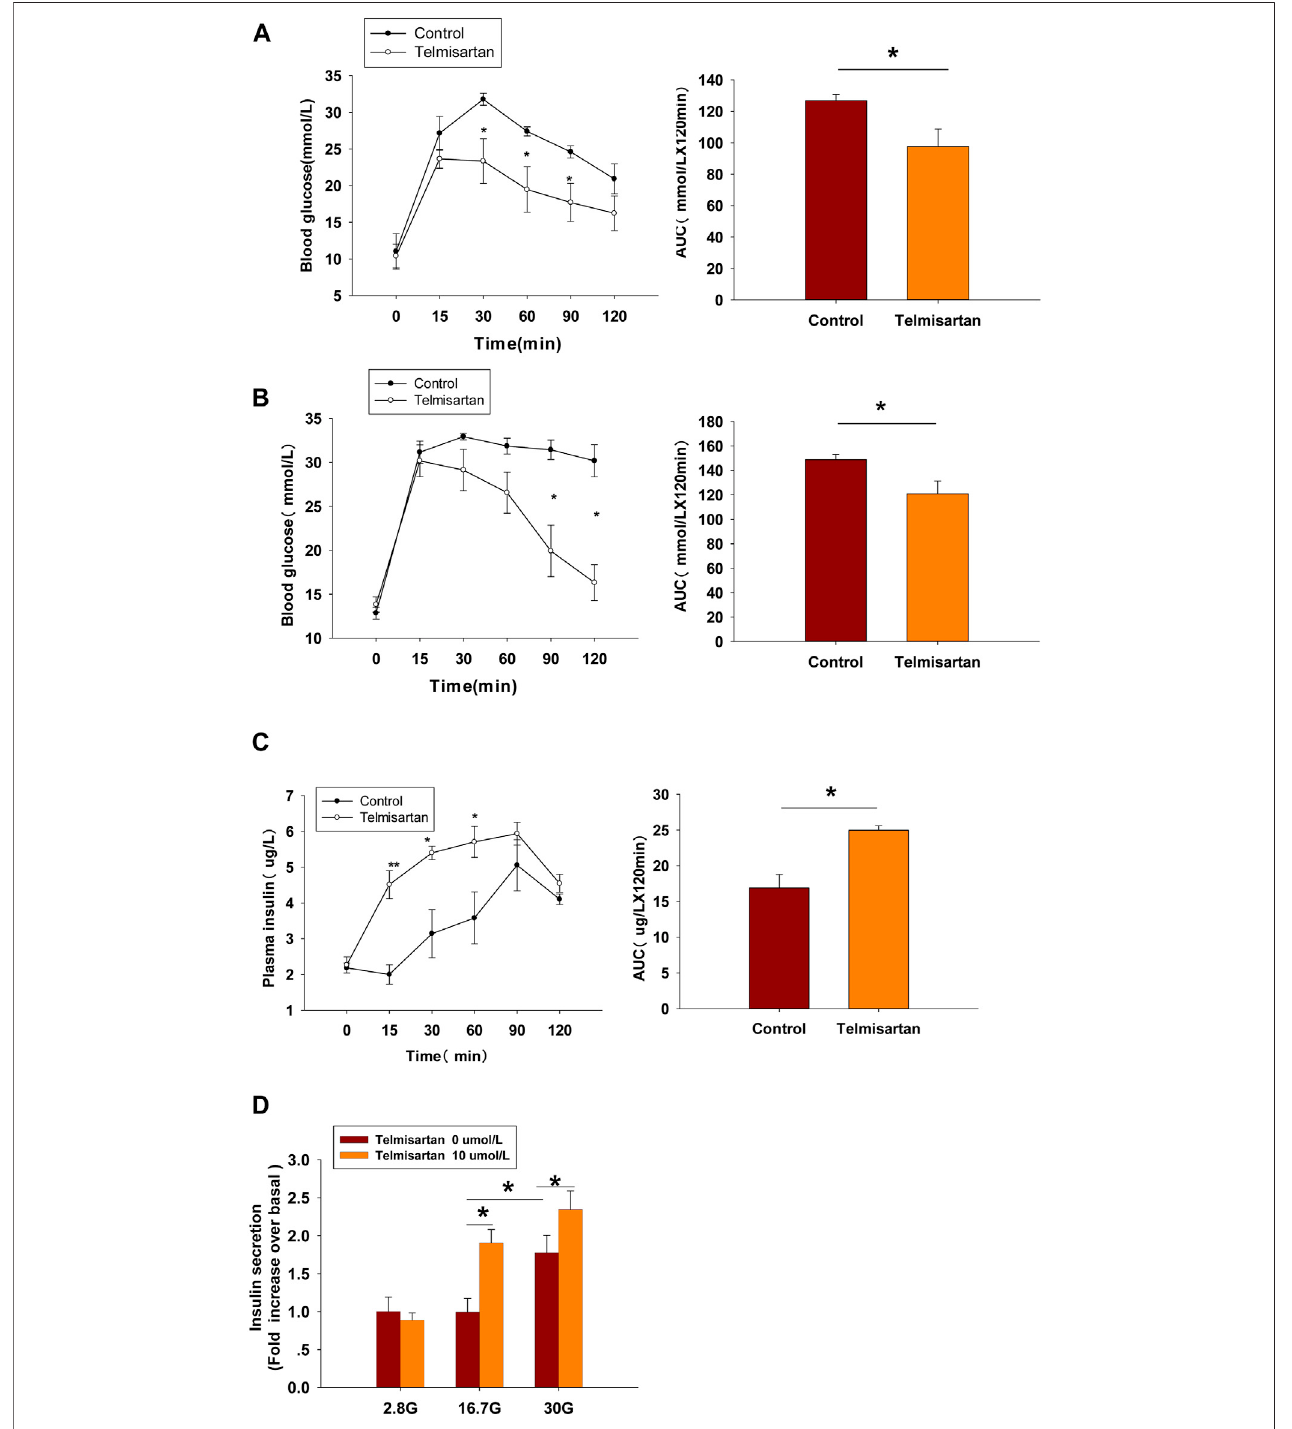
FIGURE8| Telmisartanimprovesglucosetoleranceindb/dbmice,elevatesGSISlevelsinisolatedislets,andexertssimilarelectrophysiologicaleffectson β -cellsof db/db mice. (A) OGTTwasperformed and AUCs forOGTT werecalculatedfrom the datain 8-wk-old mice. (B) OGTTand AUC forOGTT in11-wk-oldmice. (C) Serum insulin levels at corresponding times and AUC in 11-wk-old mice. (D) Db/db mice islets were treated with or without telmisartan (10 μ M) under different glucose concentrations (2.8, 16.7, and 30 mM) ( n (cid:1) 6 tubes of islet). (E) Representative Kv channels current trances recorded with treatment of telmisartan (10 μ M) in β -cells. (F) Current-voltage relationship curves and the summary of the mean current density of Kv channels recorded at 80 mV depolarization ( n (cid:1) 6 cells). (G) RepresentativeCa 2+ currenttrancesrecordedwithtreatmentoftelmisartan(10 μ M)in β -cells. (H) Current-voltagerelationshipcurvesandthesummaryofthemeanCa